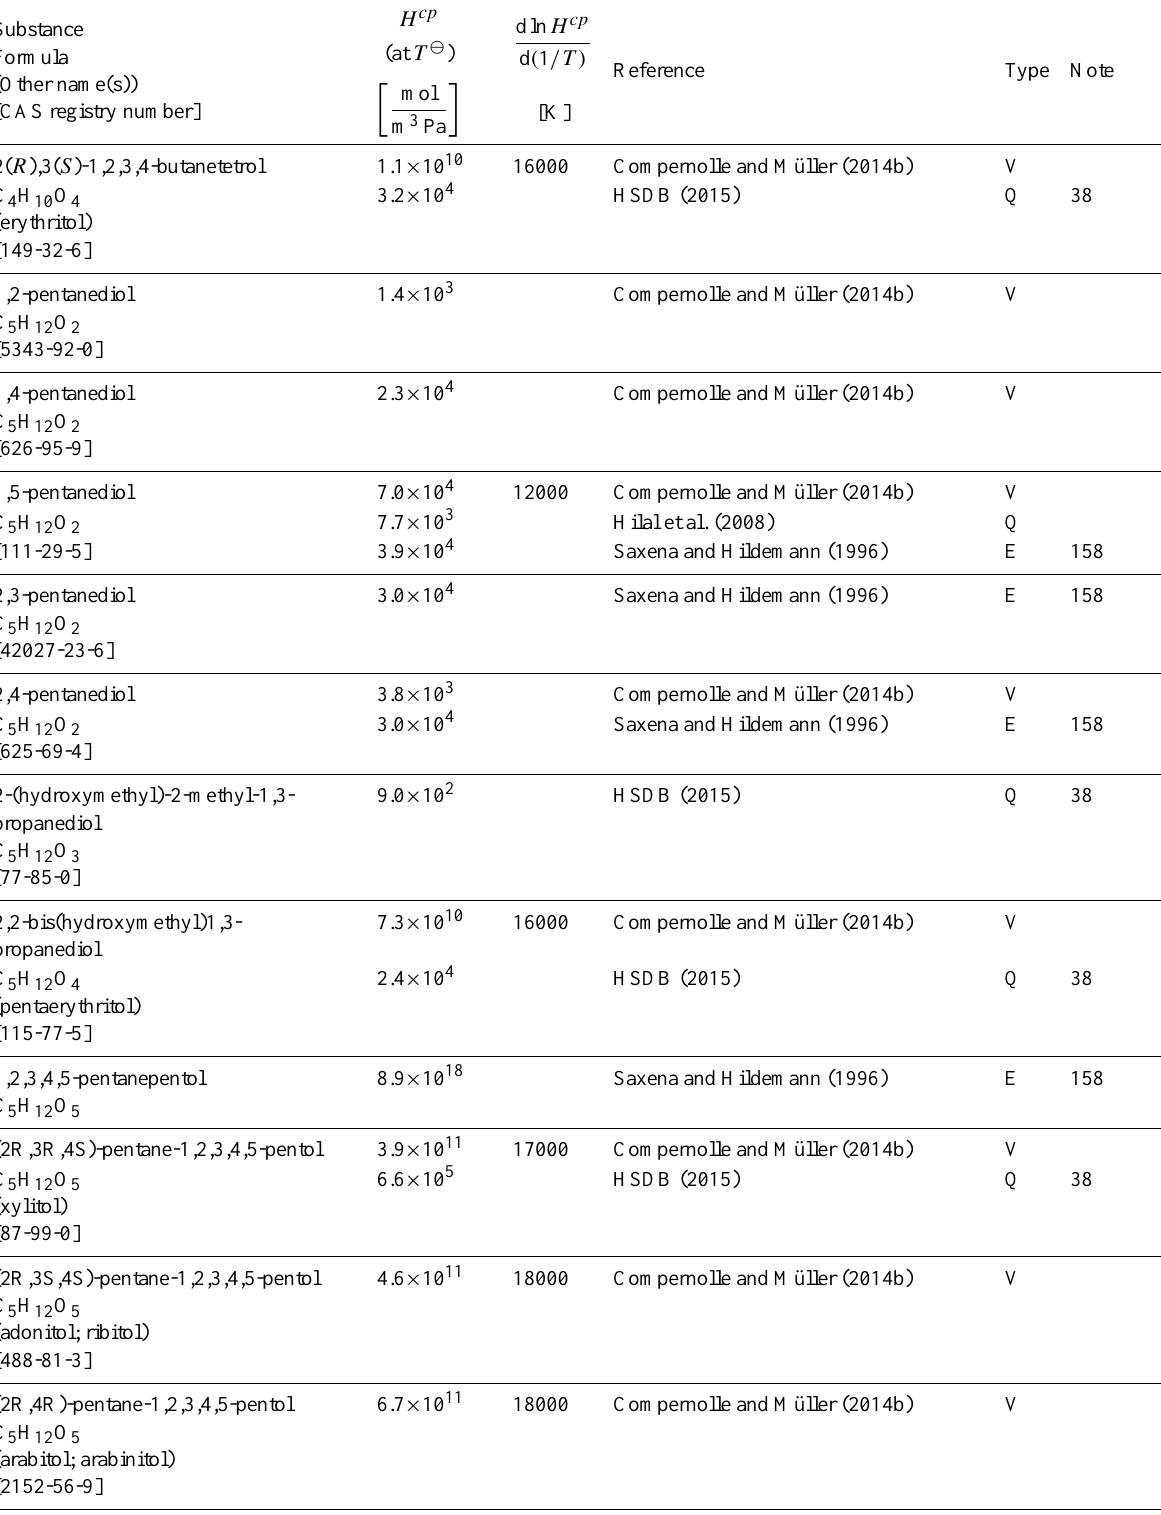
Table 6: Henry’s law constants for water as solvent